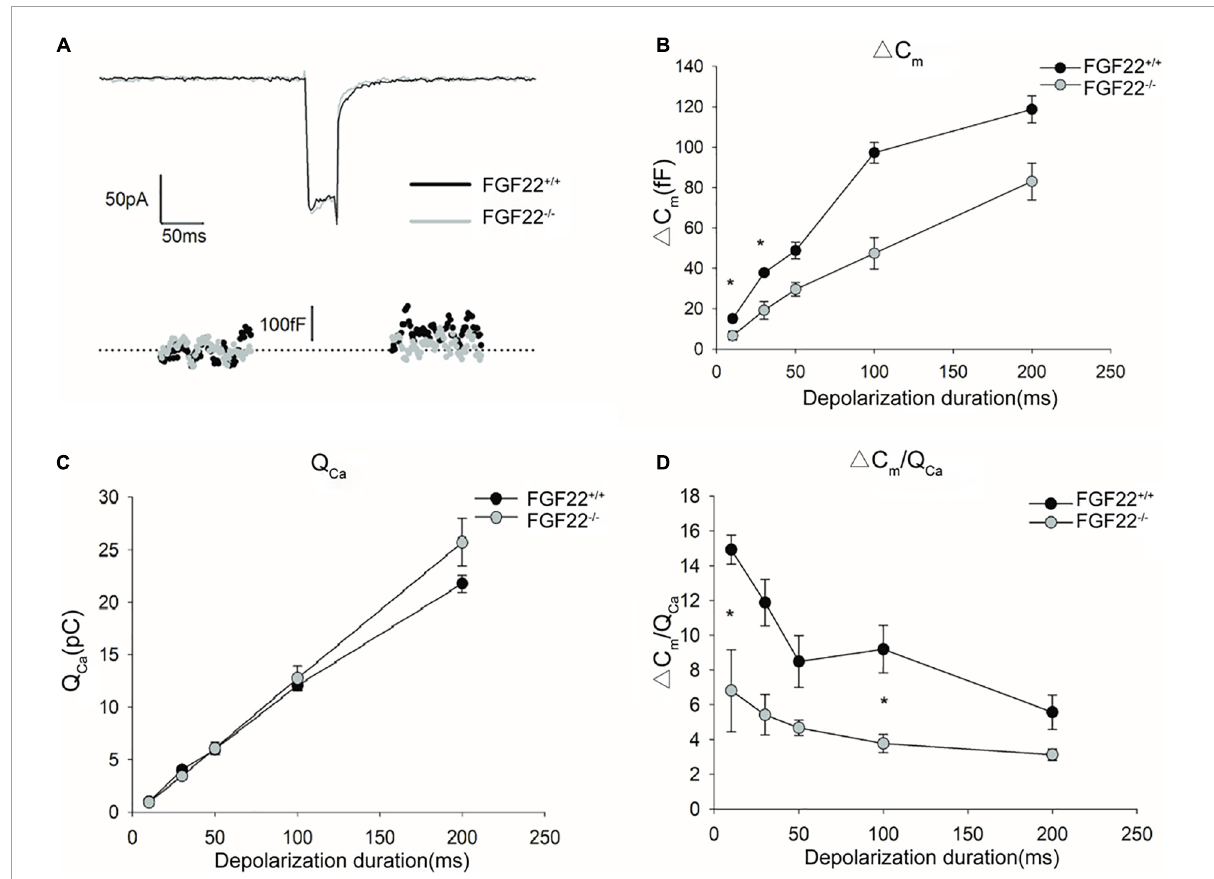
FIGURE6 Changes in exocytosis in IHCs between the Fgf22 + / + and Fgf22 − / − groups. (A) Representative Ca 2 + currents ( I Ca ) and the resulting capacitance jumps ( (cid:49) C m ) recorded from IHCs between the Fgf22 + / + (black) and Fgf22 − / − (gray) groups. (B,C) (cid:49) C m and the Ca 2 + charge ( Q Ca ) evoked by stimulations of different durations, from 10 to 200 ms. (cid:49) C m for stimulation of 10 and 30 ms was significantly reduced in the Fgf22 − / − group, * P = 0.0301, and P = 0.0251 < 0.05, respectively. (D) The Ca 2 + efficiency of triggering exocytosis, assessed based on the ratio of (cid:49) C m / Q Ca , was reduced significantly for stimulation of 10 and 100 ms in the Fgf22 − / − group. Data are expressed as the mean ± SD. *Indicates significant differences with P = 0.0476, and P = 0.0201 < 0.05,